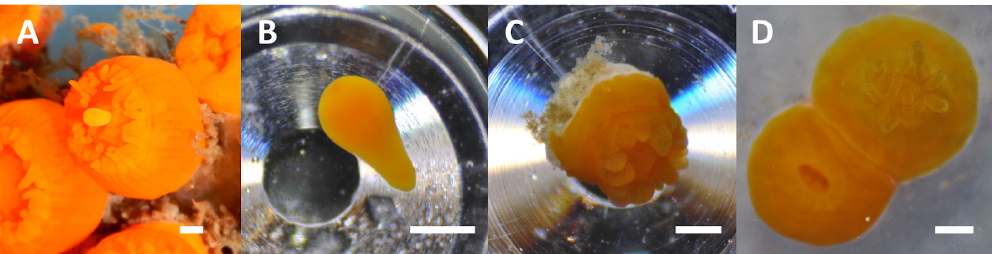
Figure 1. Early life stages of Astroides calycularis (a) spawning of a larva from the mouth of a female polyp, (b) a larva after 15d, (c) a non-settled metamorphosed polyp after 1 week and (d) a settled metamorphosed polyp with two polyps after 1 week. Scale: 1mm. See also Videos S1, S2 and